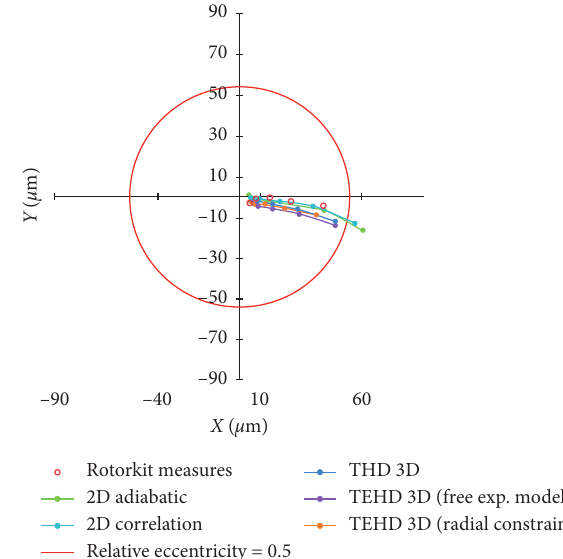
Figure 14: Mobility plot for the modified RK with respect to 3D numerical THD and TEHD simulation results in configuration